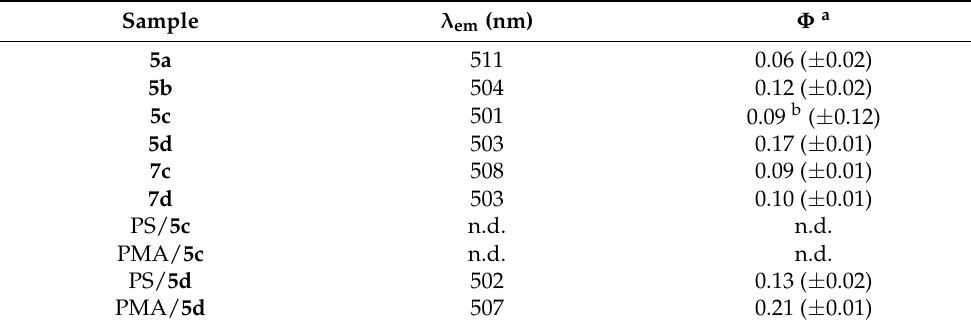
Table 3. Quantum yield of Cu(I) complexes, metallopolymers and blends in solid state at room